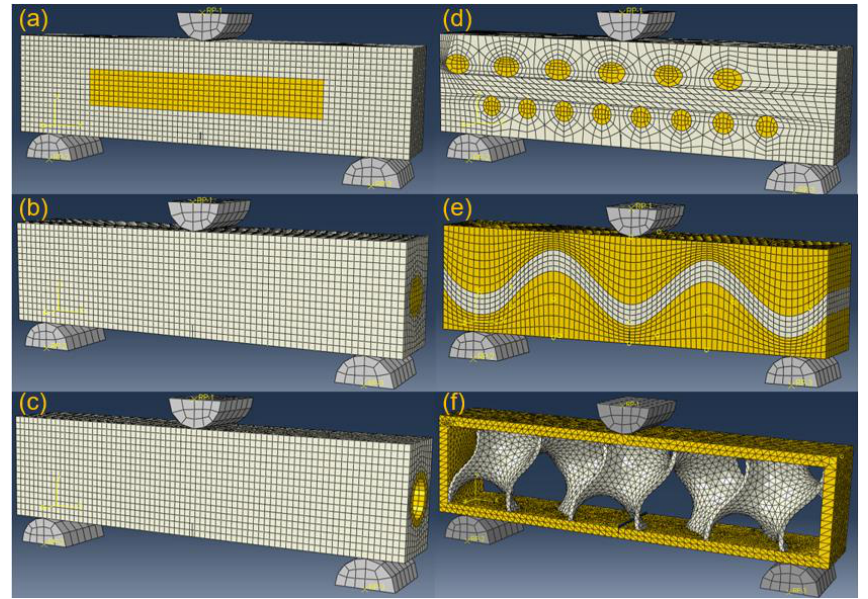
Figure 13. Simulation setup of three-point bending test of the six bionic models. ( a ) Layered ( b ) Columnar ( c ) Tubular ( d ) Helical ( e ) Sutured ( f ) Sandwich. ( b ) Columnar ( c ) Tubular ( d ) Helical ( e ) Sutured ( f )